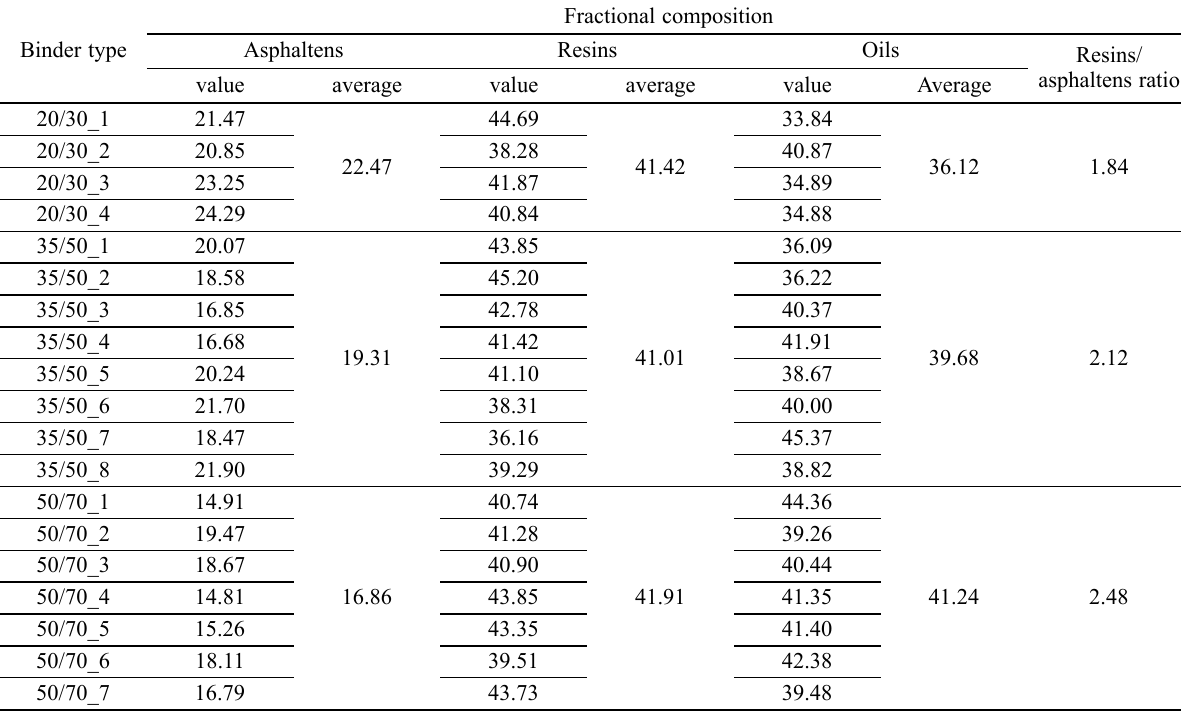
Fractional composition